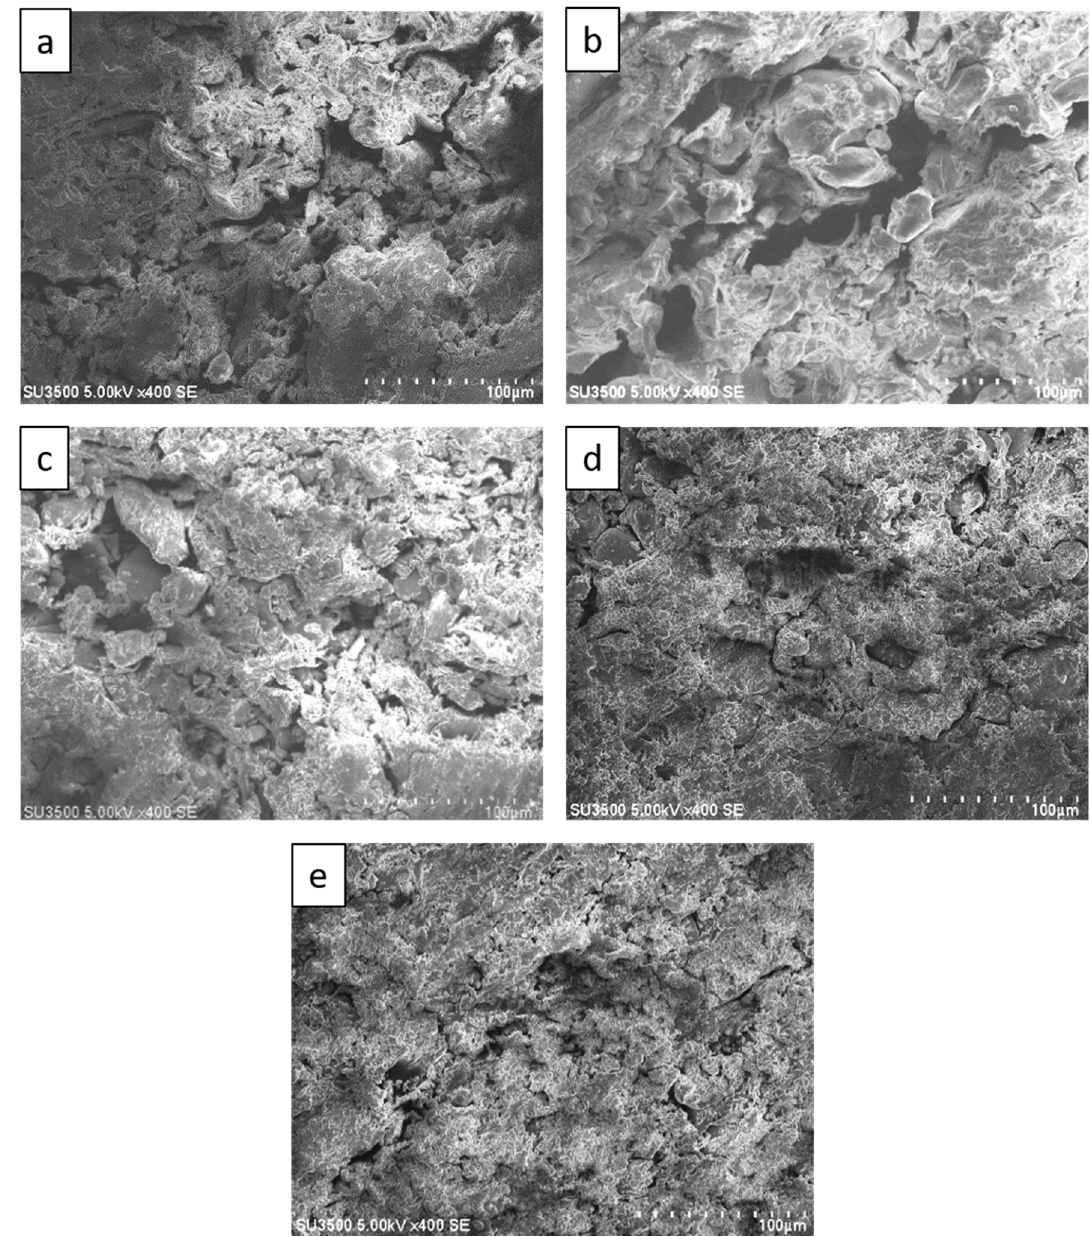
Figure 5. SEM images of sago fiber-epoxy composites: ( a ) E9, ( b ) E13, ( c ) E17, ( d ) E20, and ( e ) E23.